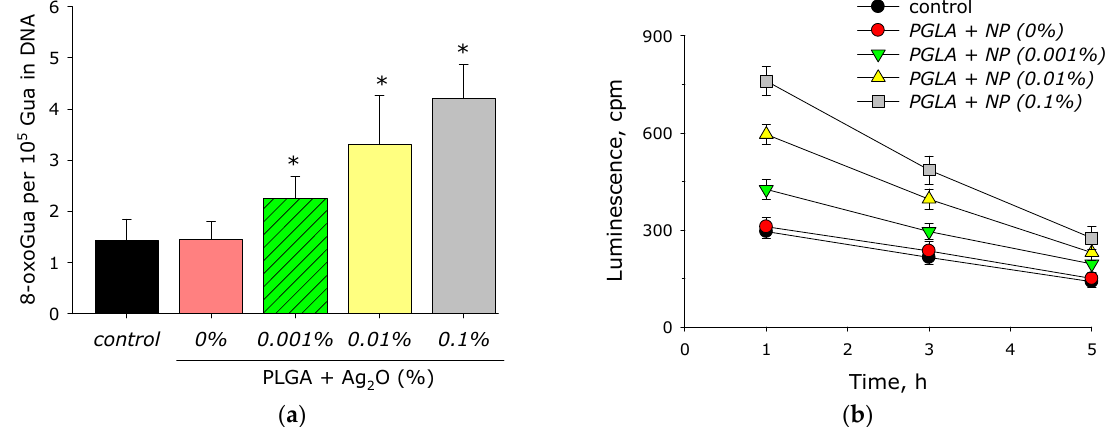
Figure 9. Effect of composite PLGA/Ag 2 O NPs on the biomacromolecules damage formation: ( a ) generation of 8-oxo-G in DNA in vitro (2 h, 45 °C); ( b ) formation and dynamics of decomposition of long-lived reactive protein species (2 h, 40 °C); *— p < 0.05 versus control. Data are presented as mean ± SE.